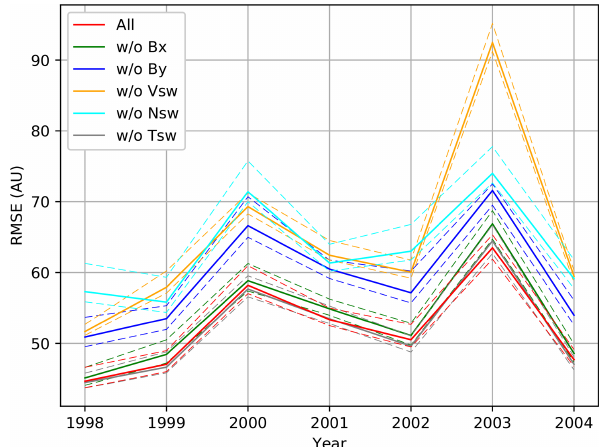
Figure 6. RMSE in each year for the various synthetic AU indices with the effect of one of the solar-wind parameters excluded.